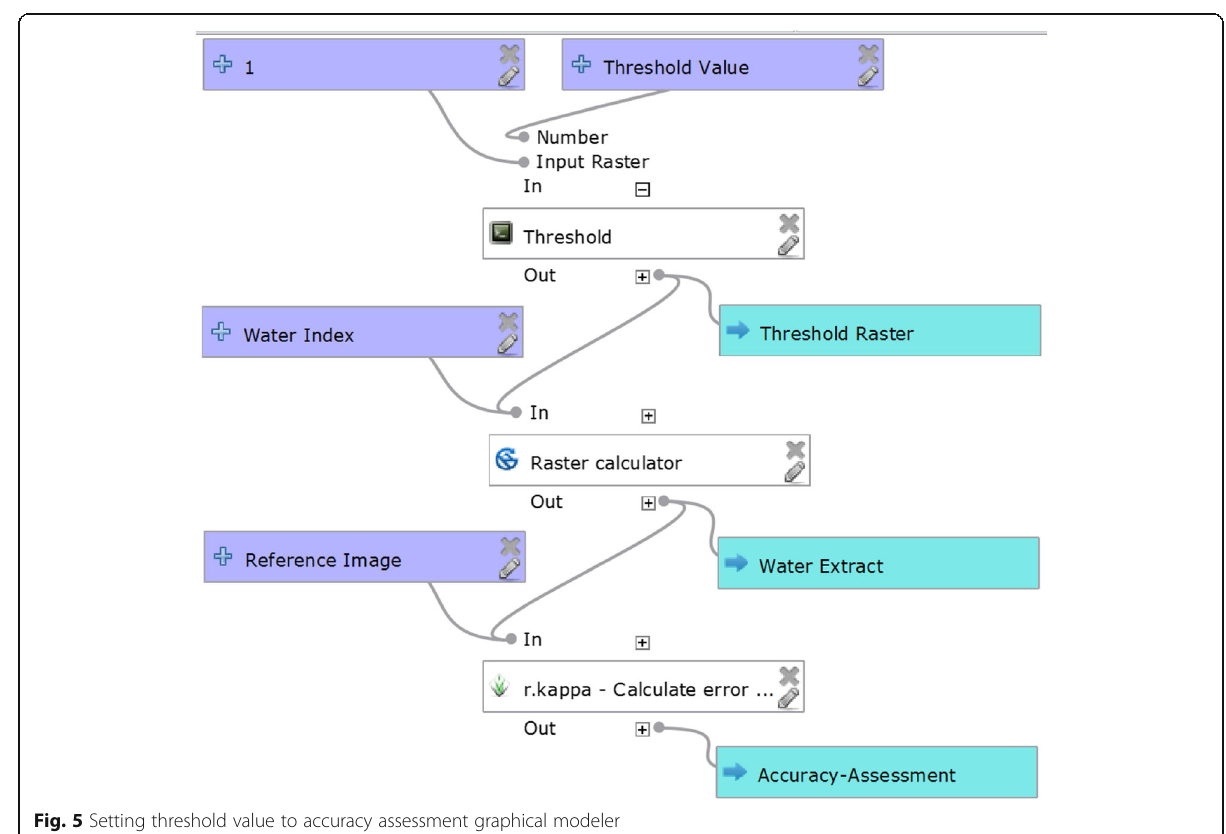
Fig. 5 Setting threshold value to accuracy assessment graphical modeler